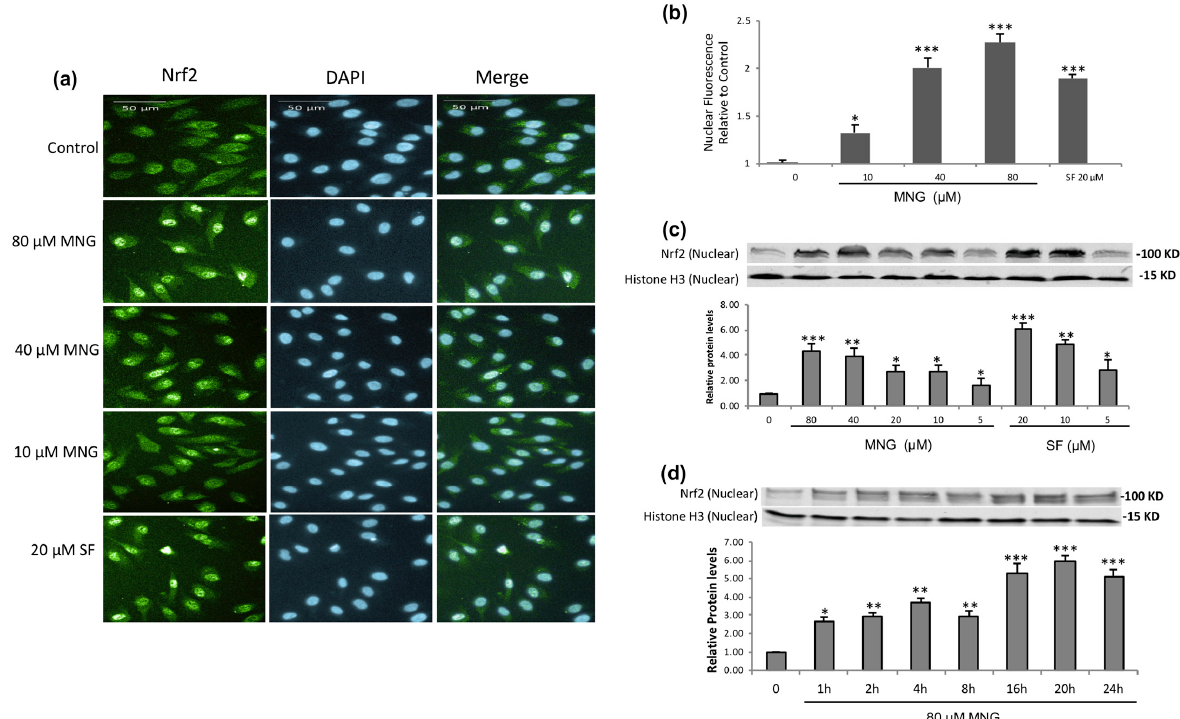
Figure 4. Effects of MNG on nuclear translocation of Nrf2 in EA.hy926 cells. ( a ) Representative images in EA.hy926 cells. Nuclei were stained by DAPI (blue) and transcription factors were stained by immunolabeled antibodies for Nrf2 (green). The fluorescent images were acquired by an Operetta high-content imaging system, using a 20× objective lens (Scale bar represents 50 µ m). ( b ) Average relative nuclear fluorescence was quantified by the intensity of fluorescence from individual cells. ( c ) Cells were incubated with MNG and SF at the indicated concentrations for 24 h. The protein expression of Nrf2 in nuclear extracts was examined by Western blot. Histone H3 was used as loading control for nuclear extracts. ( d ) EA.hy926 cells were treated with 80 μ M MNG for the indicated durations. The Nrf2 protein translocated into nuclei was analyzed by Western blot. The data in the figure represent the mean ± SEM of 3 independent experiments. * p < 0.05, ** p < 0.01 and *** p < 0.001 compared with the control group.